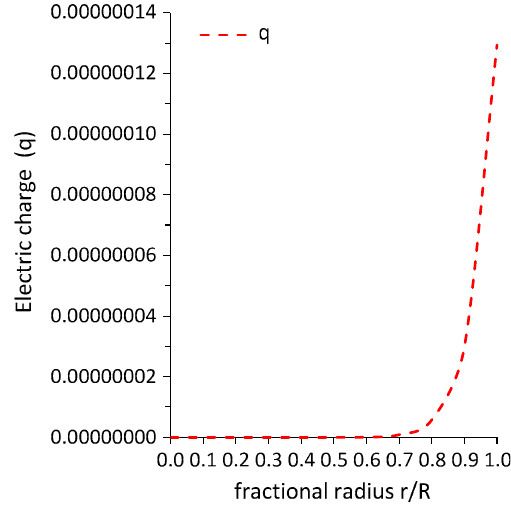
Fig. 10 Behavior of the difference of sound speeds V 2 same data set of numerical values as used in Figs. 1, 2, 3, 4, 5, 6, 7, 8 and 9